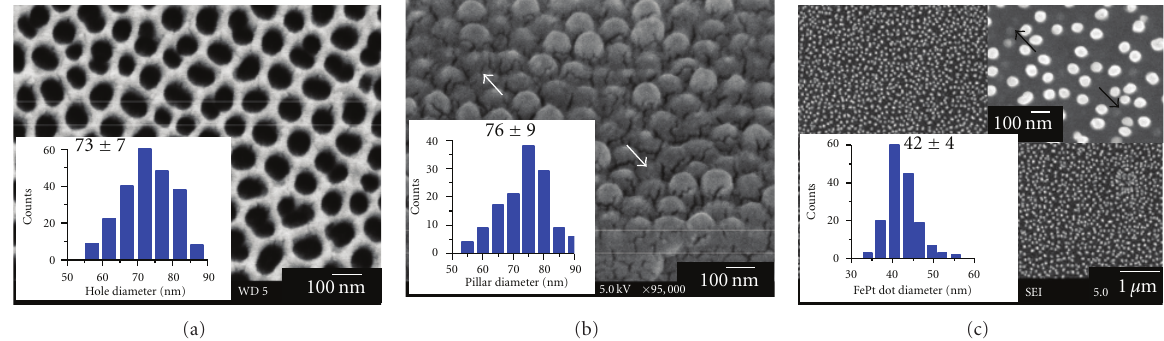
Figure 3: SEM plane-view images of (a) AAO mold coated with thin SiO 2 layer; inset is the distribution of pore diameter of the mold, (b) the cross-sectional SEM image of as-imprinted resist pillars, and inset is the distribution of resist pillar diameter. Some pillars with smaller height are indicated by white arrows, and (c) plane-view SEM image of FePt dots on Si wafer; inset in the upper right corner is the magnified view and in left bottom corner is the size distribution of FePt dots. Some dots with reduced height are indicated by black arrows in the magnified view.